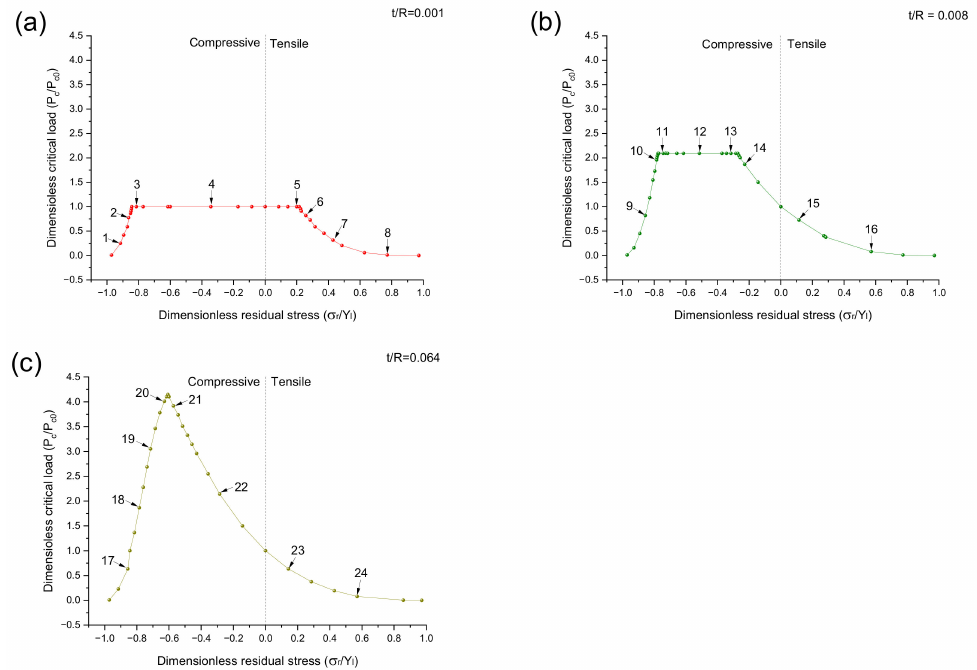
Figure 5. Dimensionless critical load versus dimensionless residual stress and dimensionless thick- ness of 0.001 ( a ), 0.008 ( b ), and 0.064 ( c ) for surface layer/substrate system pressed by a rigid hemisphere ( E s = E l = 200 GPa, Y s = Y l = 600